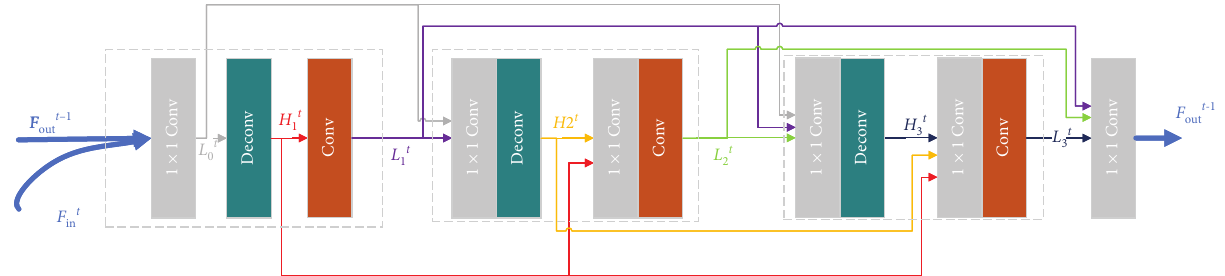
Figure 3: The Feedback Block structure with 3